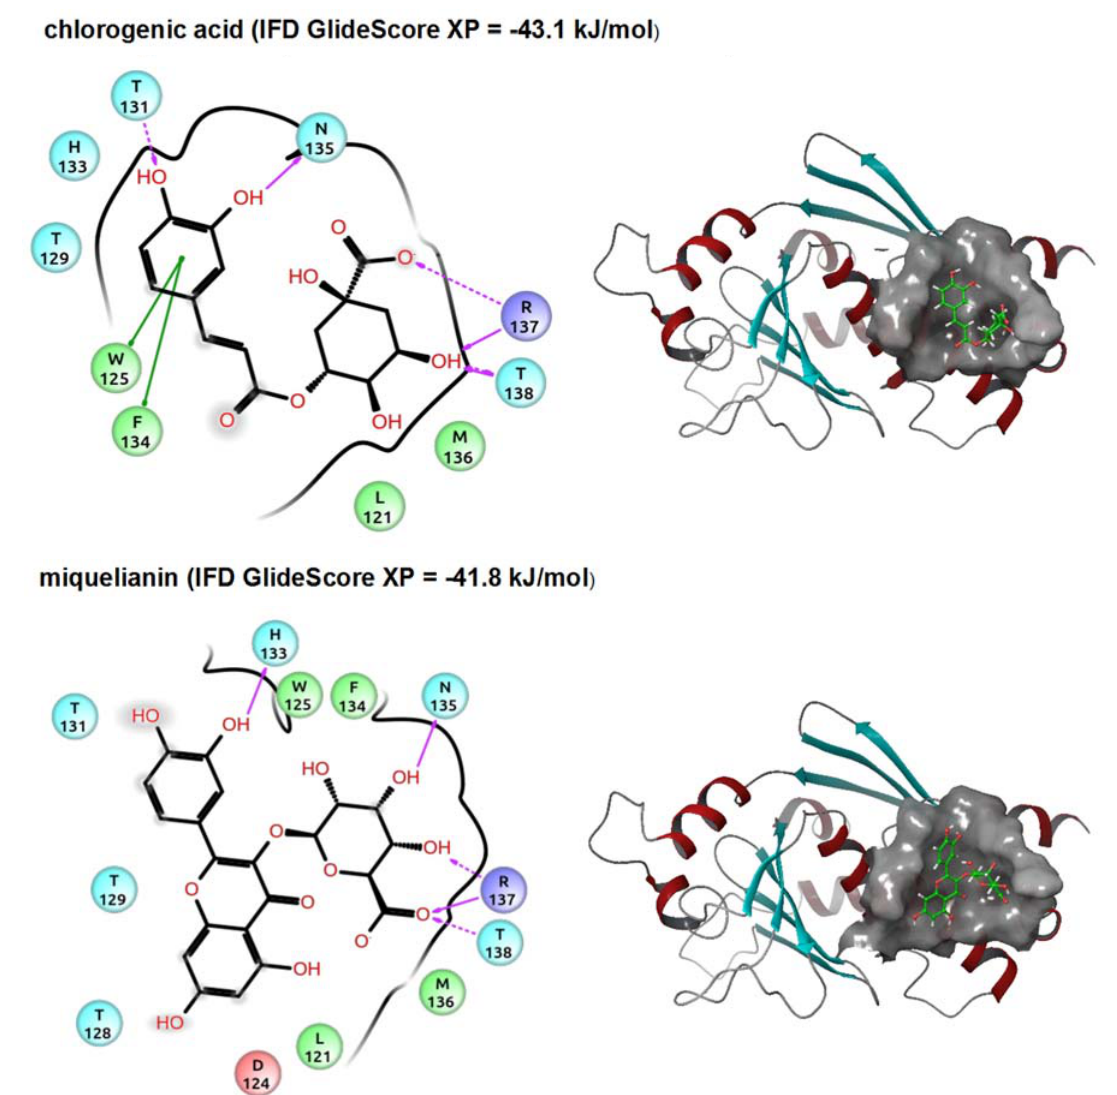
Figure 6 : Interaction maps (left) and poses (right) of chlorogenic acid and miquelianin within binding Site 1 of Ebola